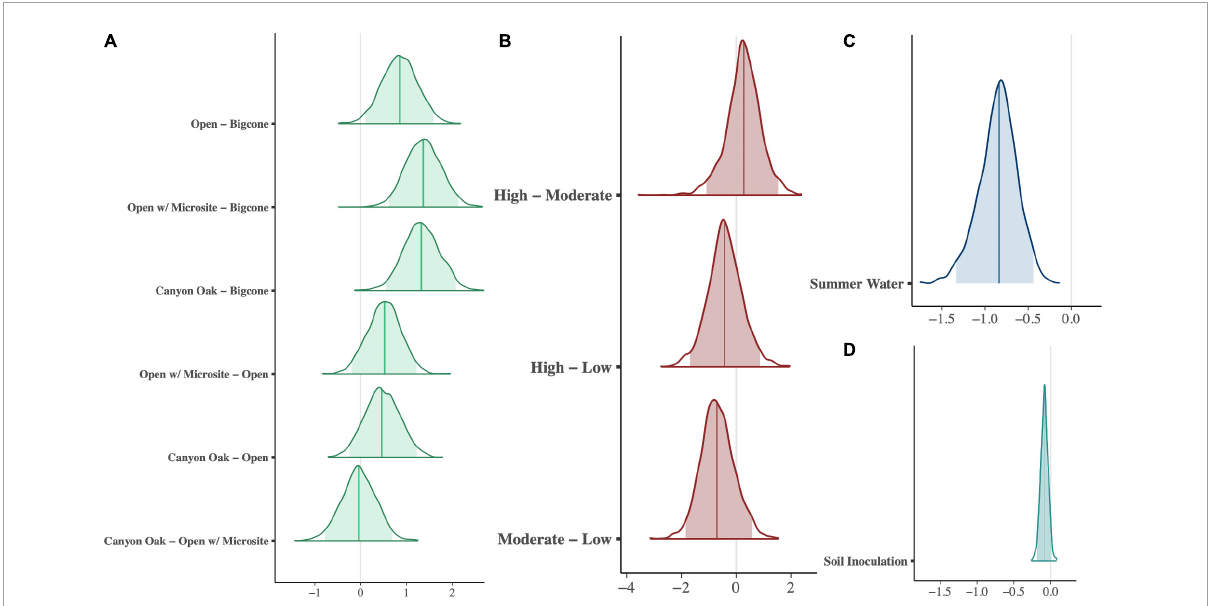
FIGURE4 Posterior distributions of parameters in seedling-survival model. Shaded regions depict 95% probability in the distribution and the vertical line shows the median estimate. For categorical terms, microhabitat (A) and fire (B) , the distributions show the contrasts between treatments. Binary terms, soil inoculation (C) and summer water (D) , are centered at zero with +1 for treated seedlings and –1 for untreated seedlings. Positive x -axis values are related to increased survival of seedlings in our model (Eqs 1,